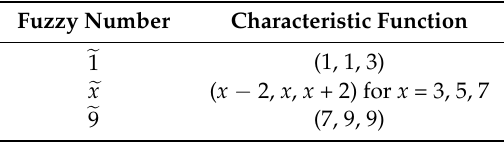
Table 1. Characteristic function of the fuzzy numbers